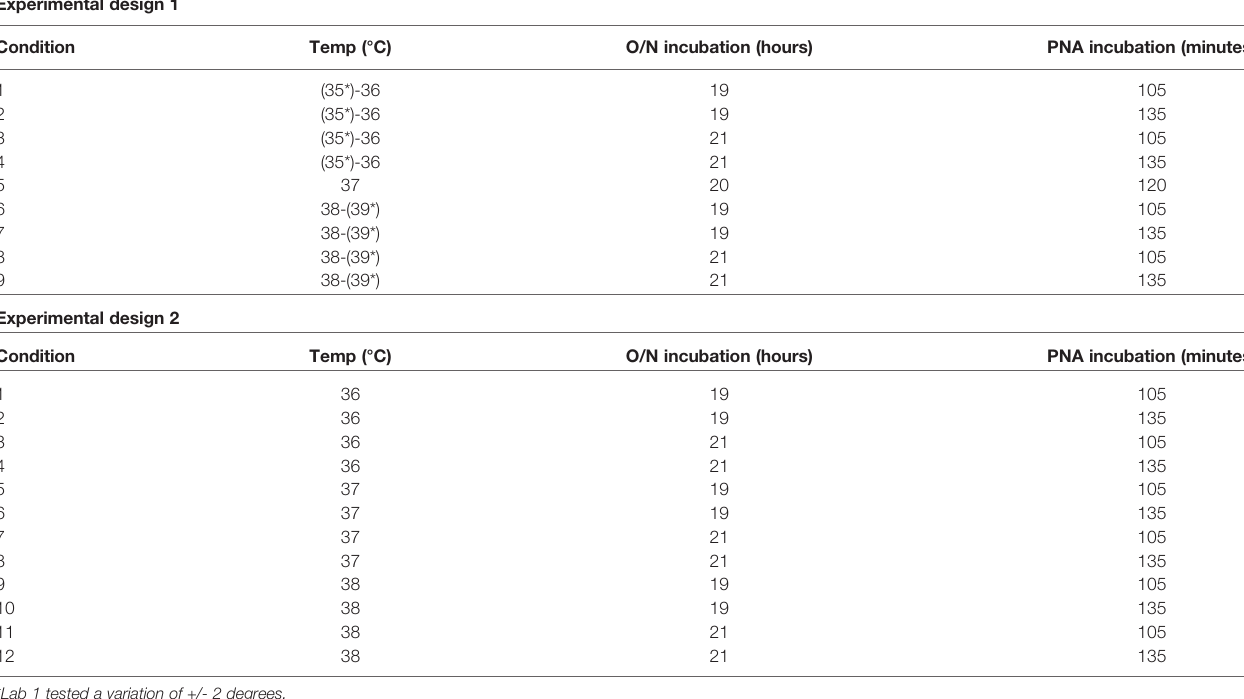
TABLE 4 | Experimental conditions for design 1 and design 2 to assess robustness of